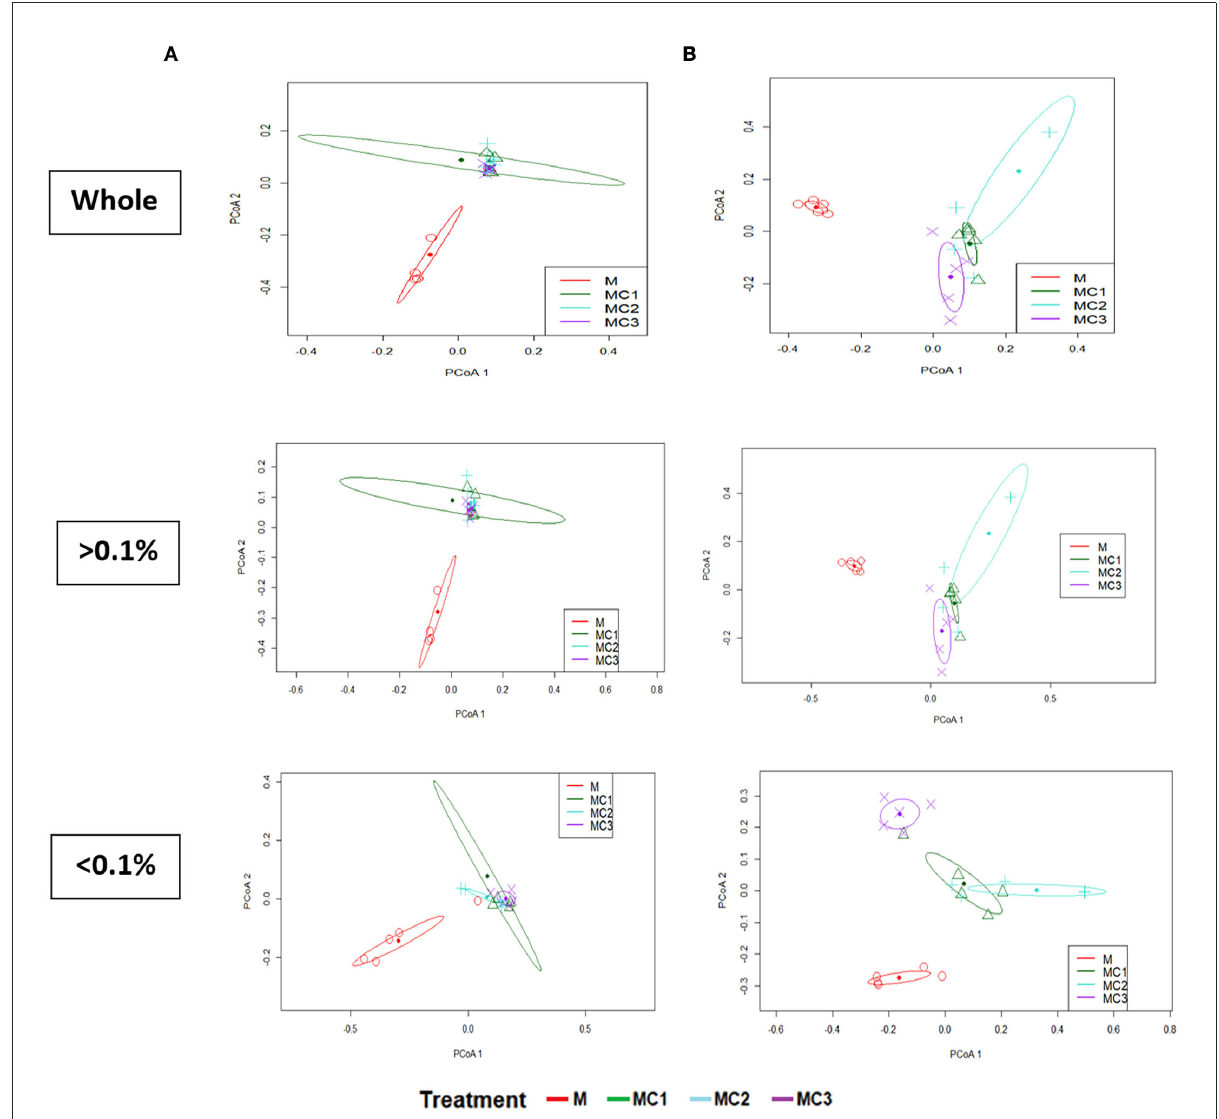
FIGURE3 Principal Coordinate Analysis of soil bacteria community ( β -Diversity) using Bray-Curtis distance for whole, most abundant, and rare taxa at the first (A) and the third (B) year under the cropping systems. > 0.1% represents the abundant taxa; < 0.1 represent the rare taxa; whole, total, M, melon monocrop; MC1, mixed intercropping; MC2, intercropping row 1:1 melon:cowpea; MC3, intercropping row 2:1